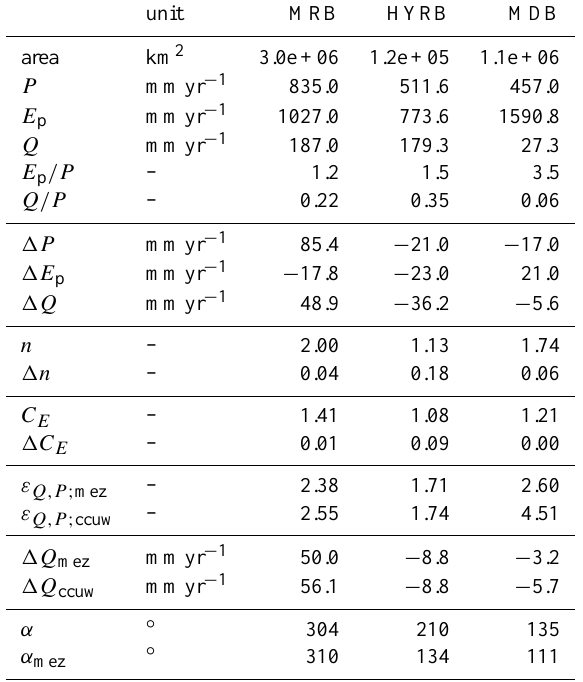
Table 1. Observations and predictions of streamflow change of three case-study river basins, Mississippi River basin (MRB), the headwaters of the Yellow River (HYRB), and the Murray-Darling River Basin (MDB). Data are taken from the respective reference publications. For prediction of streamflow change we compare the CCUW method ( 1Q ccuw ) with the sensitivity approach employing the Mezentsev function ( 1Q mez ). Change direction in UW space α , corresponding with Fig. 1, is computed by Eq. (6). The theoretical climate change direction derived for the Mezentsev function ( α mez ) is computed by Eq. (A5).